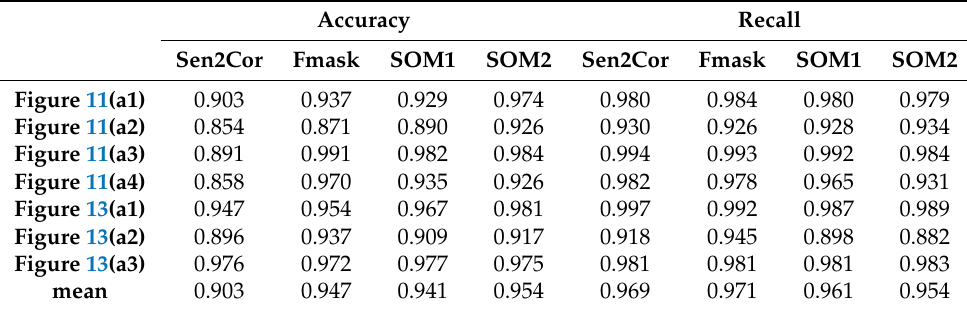
Table 5. Evaluation metrics of images with bright non-cloud objects (accuracy, recall). Accuracy